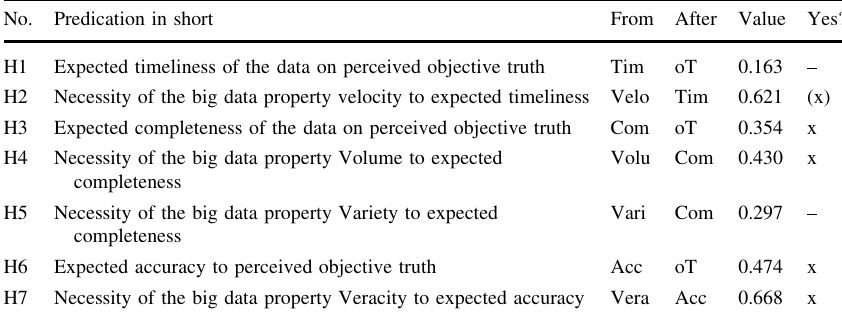
Table 7 Result of the hypothesis test by nomological